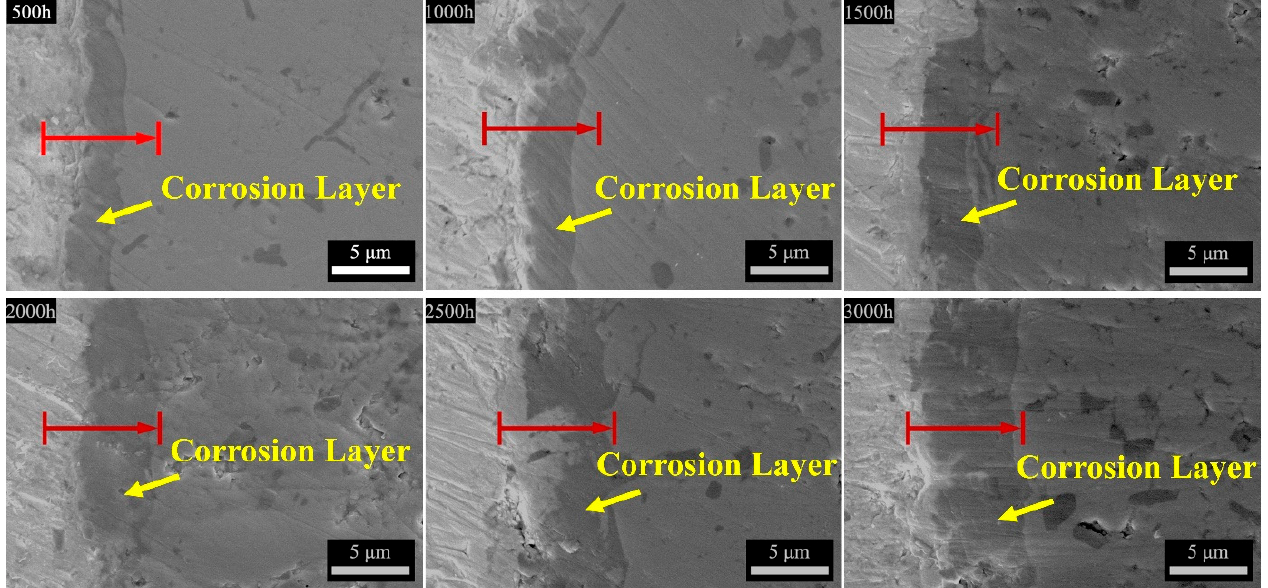
Figure 3. Cross-section morphology of Ti 3 SiC 2 after LBE corrosion for 500 h to 3000 h (The red arrows in the figures are the scanning directions of EDX).